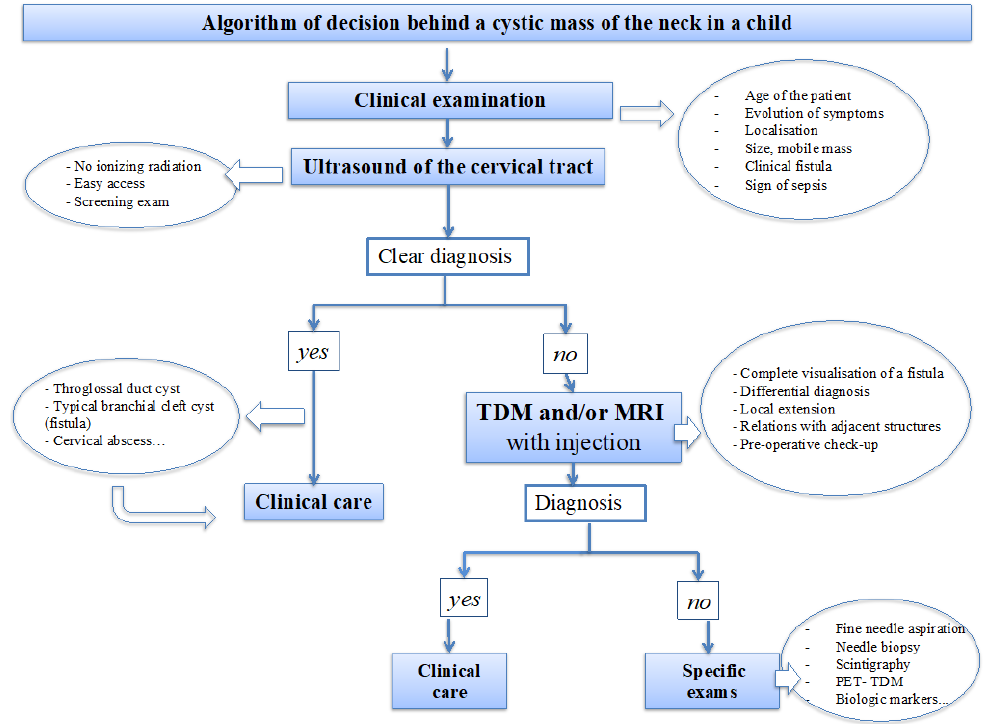
Figure 1. Diagnostic algorithm with the different steps depending on clinical examination and imaging.